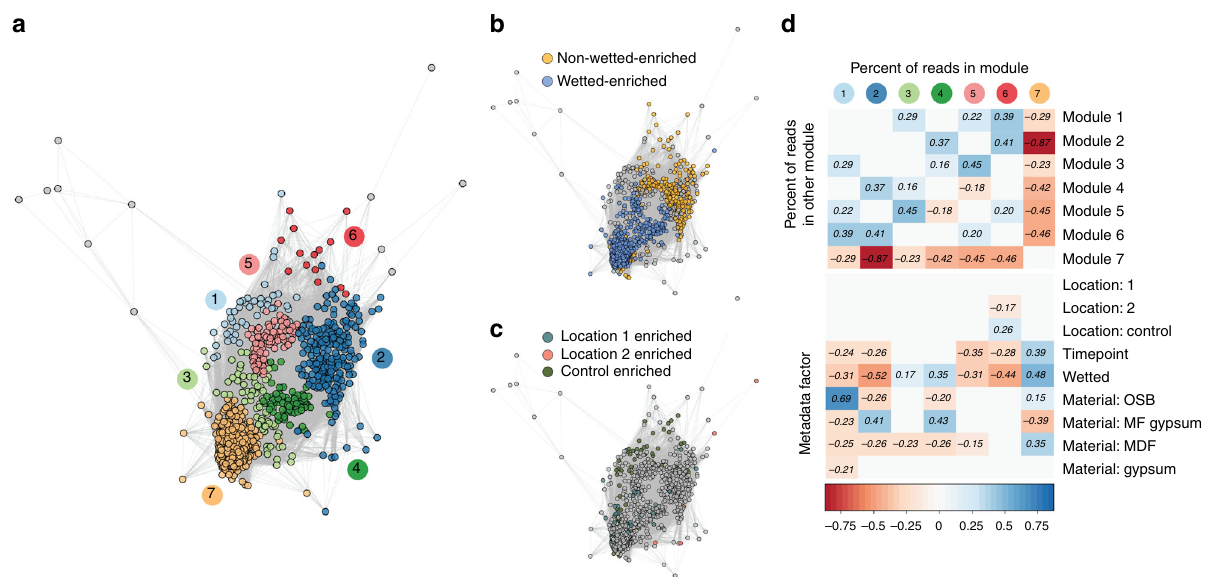
Fig. 6 Metabolite co-occurrence network. a Network of signi fi cantly positive Spearman correlations between metabolites, with network module indicated by color ( n = 144 samples). b Metabolites enriched in wet or nonwetted samples, as determined through a two-sided nonparametric t test with 10 5 permutations. c Metabolites enriched in samples originating from an individual inoculating location, with statistical methods as in b . d Correlations between metadata factors (treated as dummy variables where true = 1 and false = 0) and the percent of metabolites in network modules. Nonsigni fi cant correlations are not